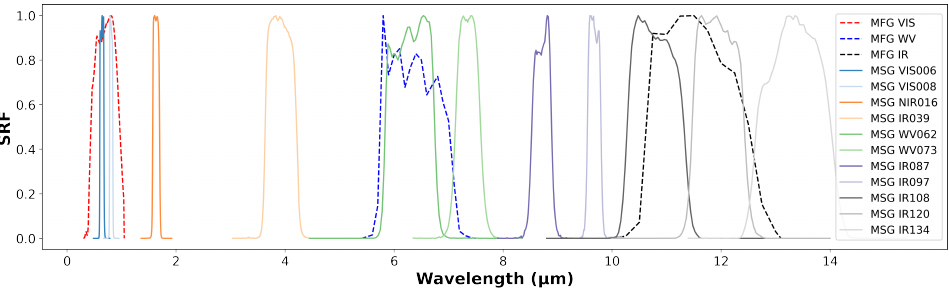
Figure 4. Spectral response curves for Meteosat-7 (MFG) and Meteosat-8